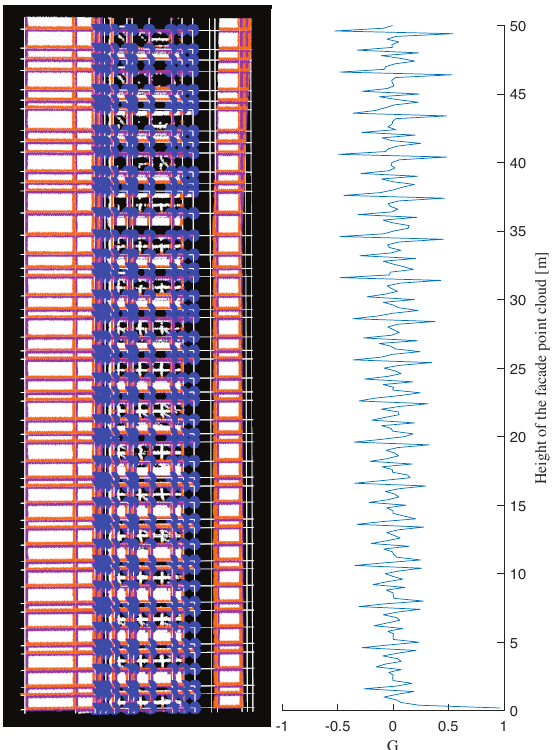
Figure 3. Result of detecting opening corners by the sliding win- dow method from the static terrestrial LiDAR data. The height and width of the fac¸ade point cloud (left) are 50 . 00 m and 16 . 81 m respectively. The plot on the right shows the gradient value in the horizontal sliding window.